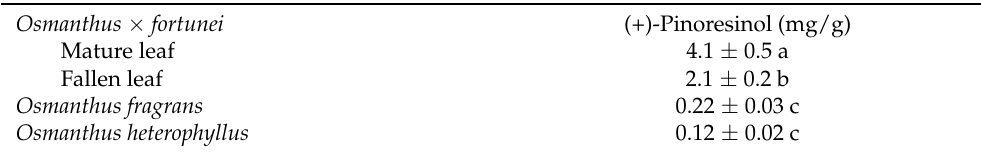
Table 4. The concentration of (+)-pinoresinol in the mature and fallen leaves of O. × fortunei , and in the mature leaves of O. fragrans and O. heterophyllus . Different letters indicate significant differences (Tukey’s HSD test, p ≤